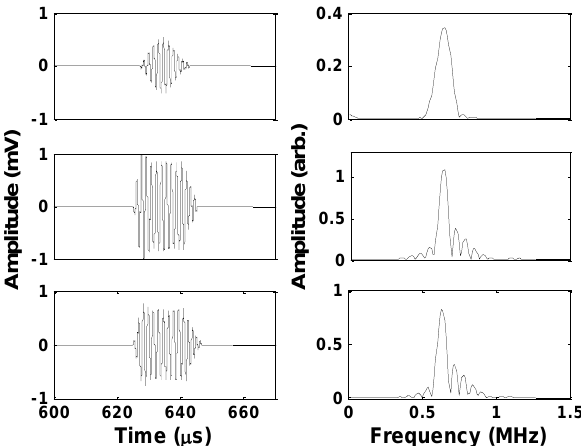
Figure 3. Time domain ( left ) and amplitude spectrum ( right ) of the received T(0,1) mode, from 10 cycles of tone-burst ( top ), unipolar square wave burst ( middle ), and bipolar square wave burst ( bottom ) excitation signals in 1 mm diameter carbon steel rod at frequency of 625 kHz after travelling down the immersed sensor rod in a viscous liquid and reflection from the distal end.